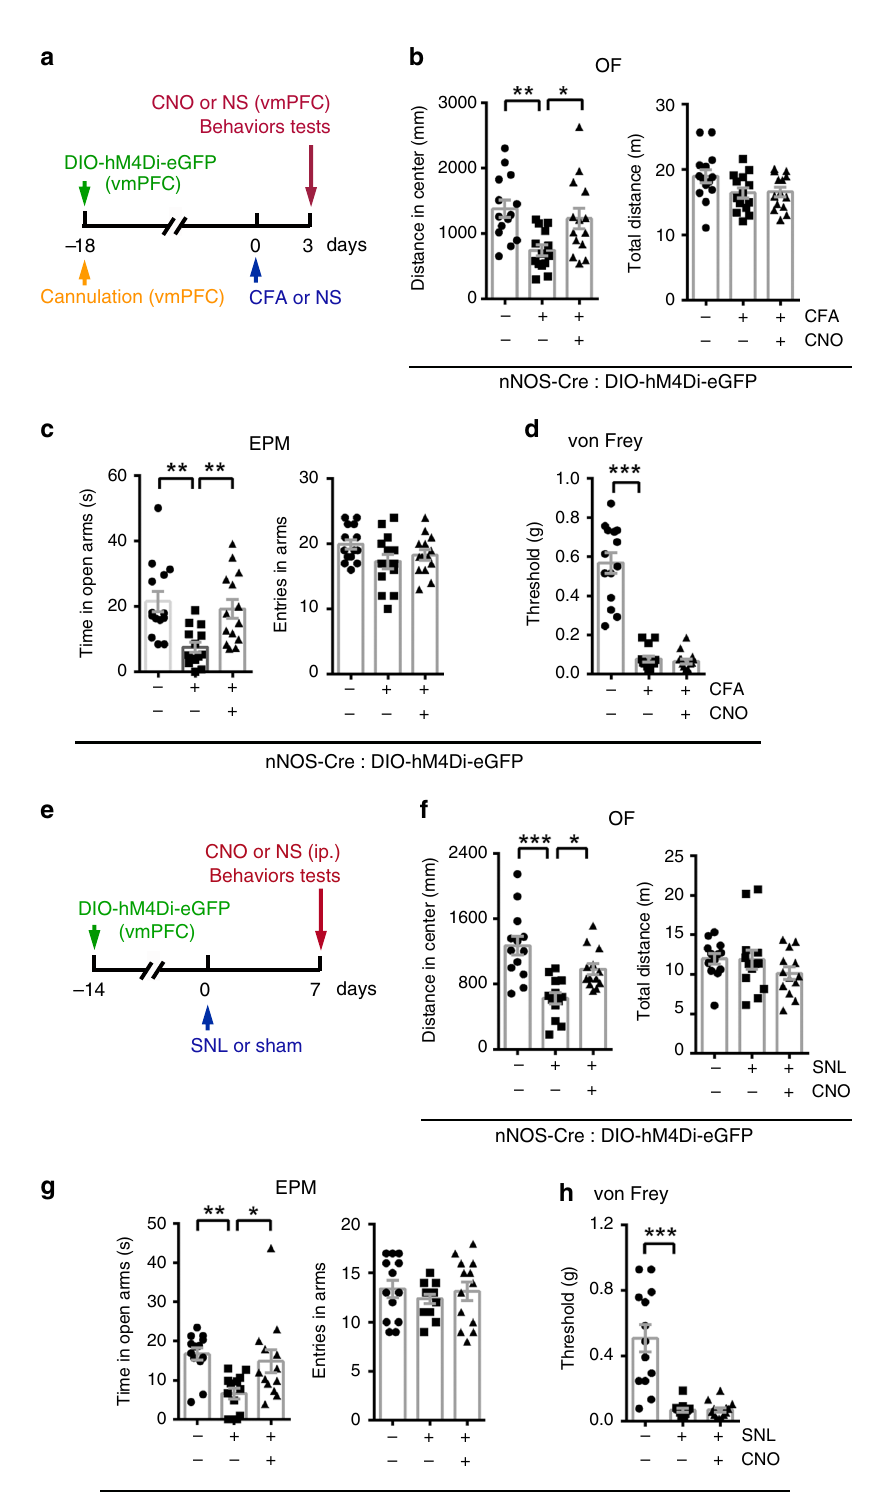
surrounded by ChR2-eYFP + projections from the pPVT (Fig. 4i, left). Then, nNOS-Cre mice were sacri fi ced for brain slice preparation. The vmPFC inputs from the pPVT were optically stimulated by blue light, and the evoked glutamatergic excitatory postsynaptic currents (eEPSCs) were recorded from a vmPFC nNOS-expressing neuron, which was visualized by Cre- dependent mCherry expression (Fig. 4i, right). As shown in Fig. 4j, eEPSCs were evoked on 41 out of 48 neurons by